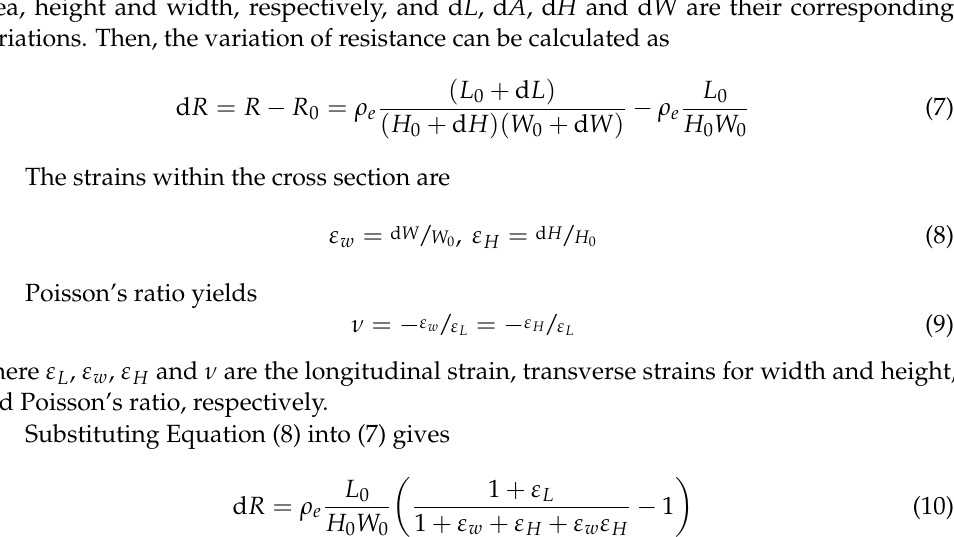
Figure 9. Gauge factor as a function of cross-sectional area of printed strain-gauge patterns. The black dots and green squares are for the width and the number of stacked layers, respectively.